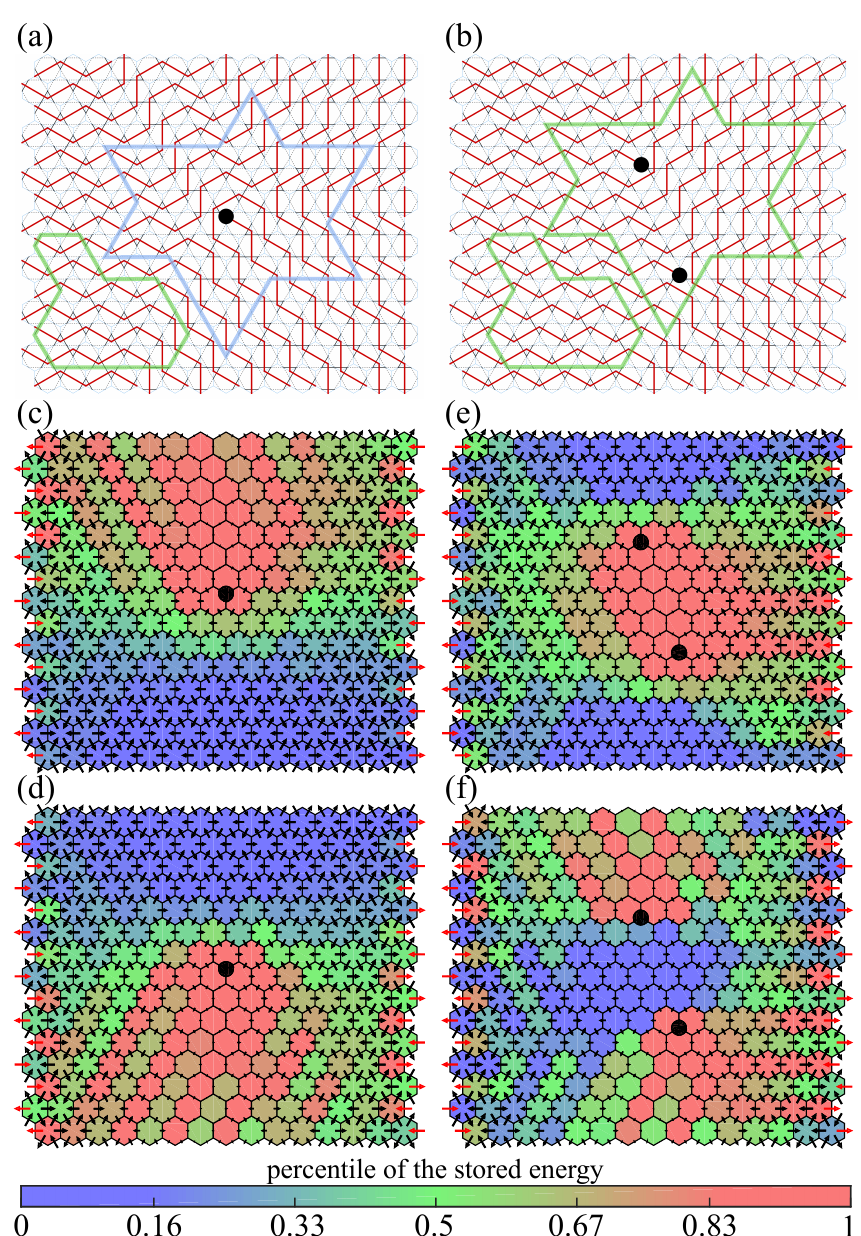
Figure 4: (a) Single defect, and (b) two defects (black circles), where director lines terminate or branch and where triangular plaquettes of the kagome lattice have an odd number of antiferromagnetic bonds. Loops of interaction bonds consisting of an even (green) or odd (blue) number of antiferromagnetic bonds. (c-f) Displacement conditions at the left and right boundaries (red arrows) lead to displacements of the facets (black arrows) and to finite elastic energy stored in each building block (color-coded hexagons). The color bar indicates the percentile of the stored energy, separately calculated for each case. Single defect (c,d): Compatible actuation on each one of the boundaries concentrates the stresses (strains) at the top (bottom) or bottom (top) half of the metamaterial. Two defects (e,f): Compatible actuation on opposing boundaries concentrates the stresses either between the defects (e) or around them (f), whereas the strains concentrate in the complementary